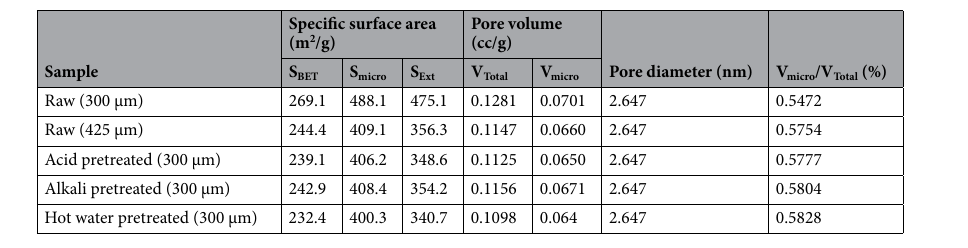
Table 10. Pore characteristics of yam peels biomass (raw and pretreated).